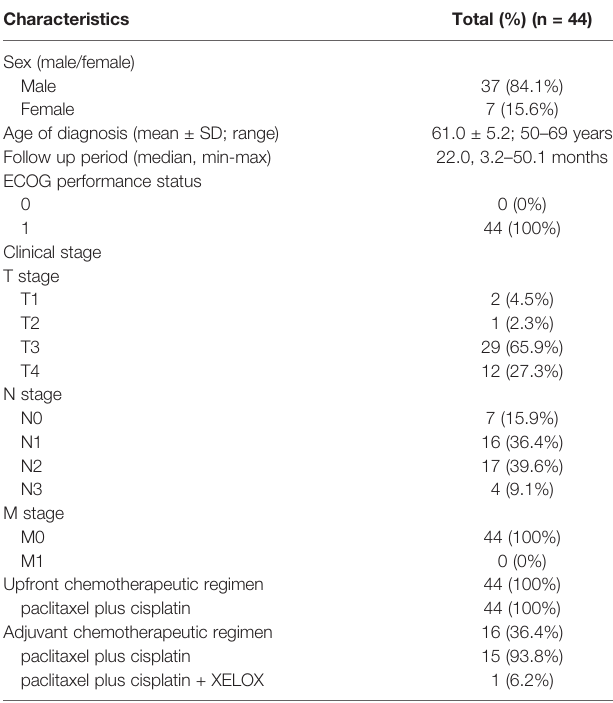
TABLE 1 | Characteristics and pathological features of esophageal cancer